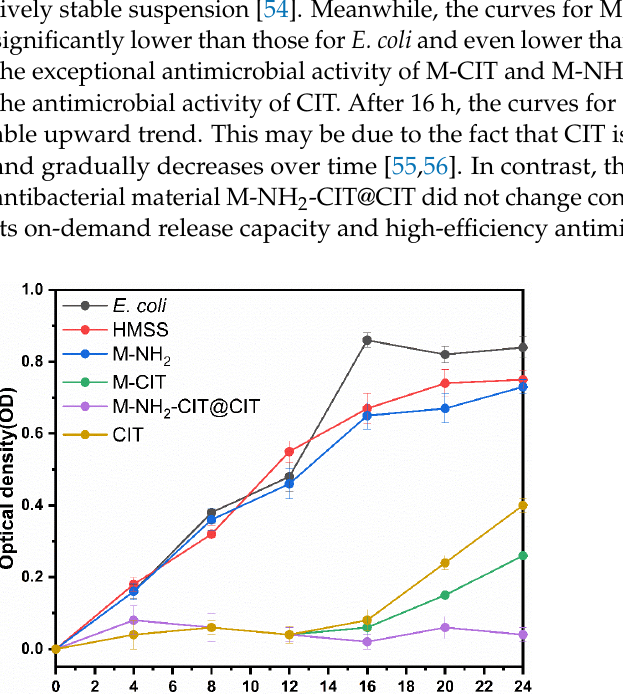
Figure 9. Antibacterial activity of the samples: colony count results of the bacterial sus- pension containing M-NH 2 -CIT@CIT (a), M-CIT (b), and the control group (c) .